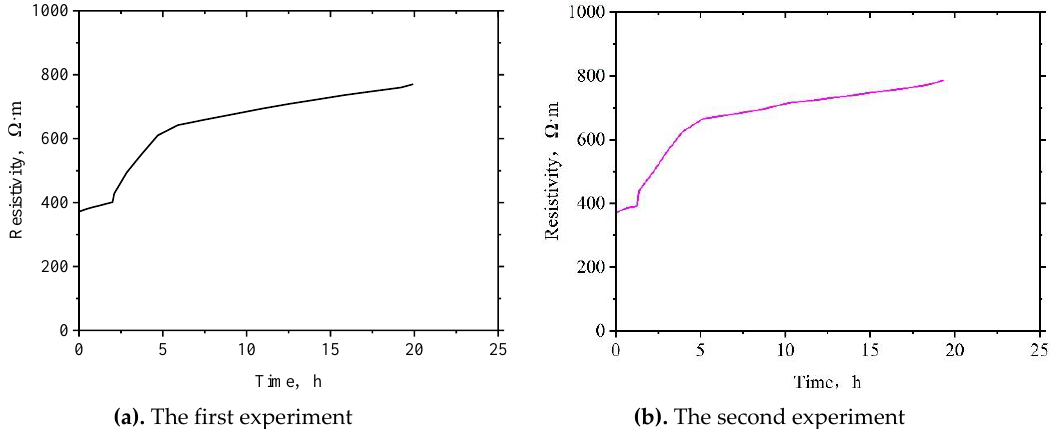
Figure 15. Resistivity changes during preparation of hydrate by three-in-one method.